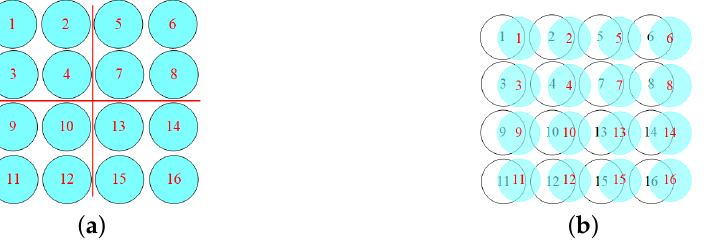
Figure 3. Image spot distribution diagram at the receiver. ( a ) Transceiver alignment. ( b ) The transceiver link misalignment.